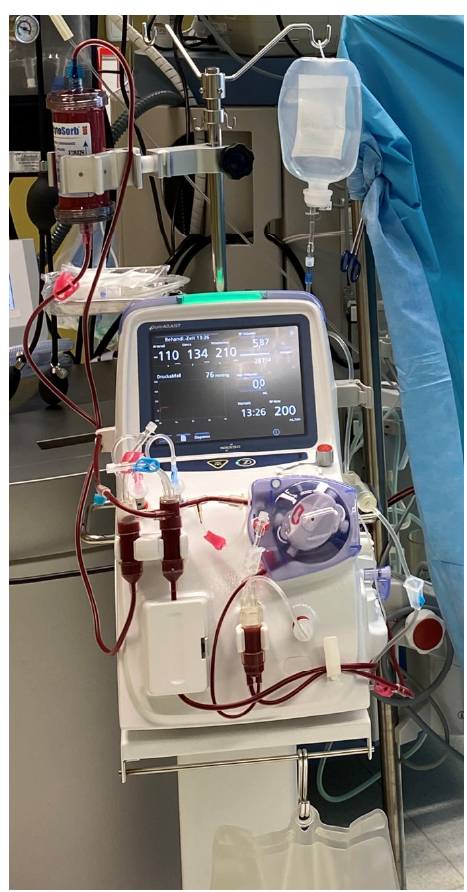
Figure 1. Apheresis machine PUR-01 (Nikkisio Co., Ltd., Tokyo, Japan) loaded with a venous blood tubing line set (ABT-023P Series, Nikkiso Co., Ltd., Tokyo, Japan) and a hemoadsorption device (CytoSorb ® 300, CytoSorbents Inc., Princeton, NJ, USA).